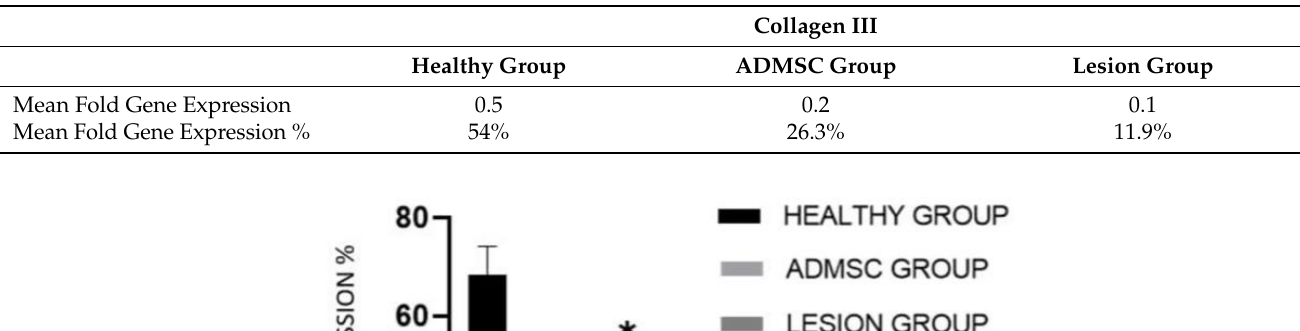
Table 3. Collagen III gene expression. Table 2. Collagen I gene expression.